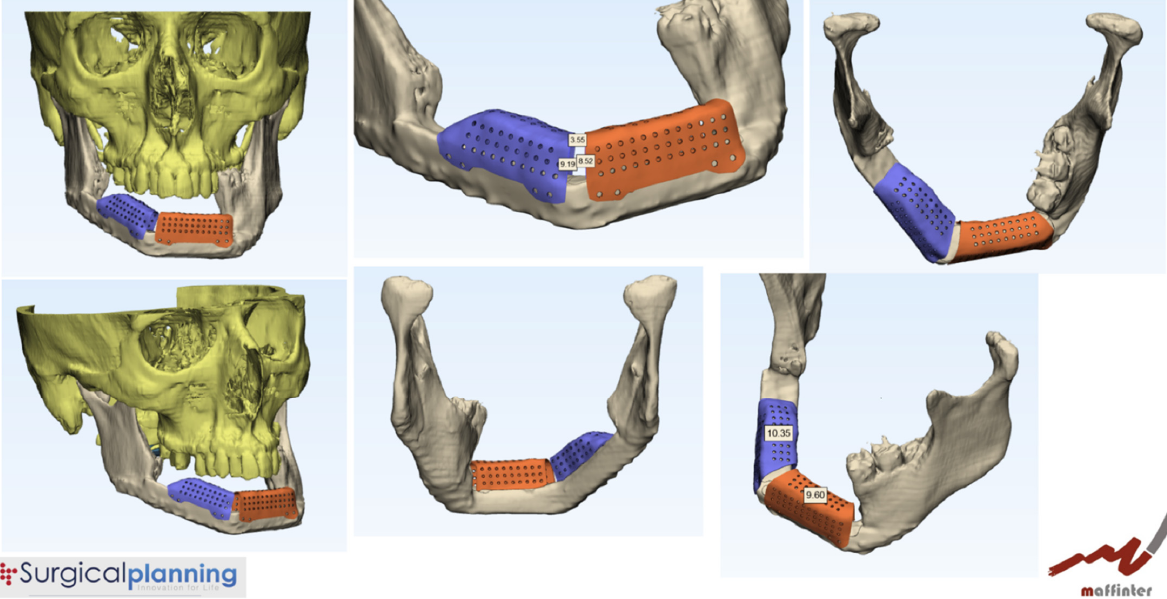
Figure 2. VSP for vertical reconstruction of the fibula with two CAD/CAM titanium meshes adapted to the two segments of the fibula flap.